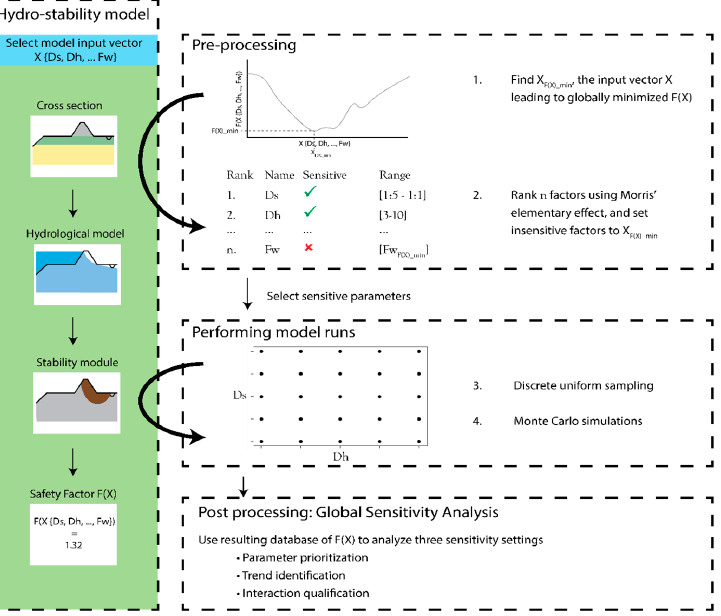
Figure 2. Workflow of Global Sensitivity Analysis, focusing on the pre-processing by factor fixing and performing the model runs. The specific measures used to qualify and quantify sensitivity are discussed in Figure 4.